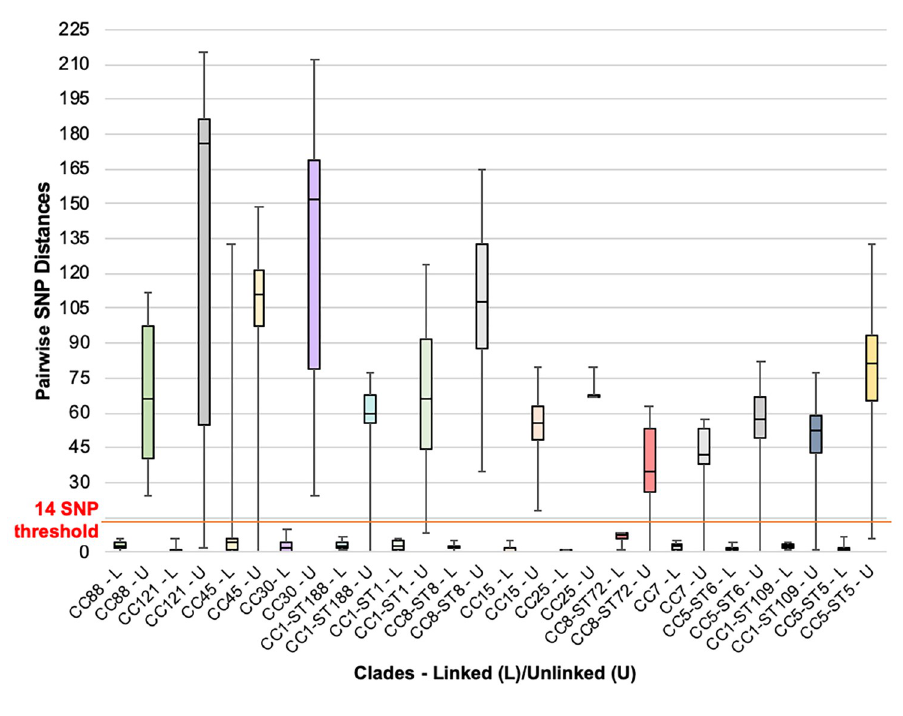
Fig 3. Pairwise SNP distances within the major clades for linked and unlinked isolates from all patients.